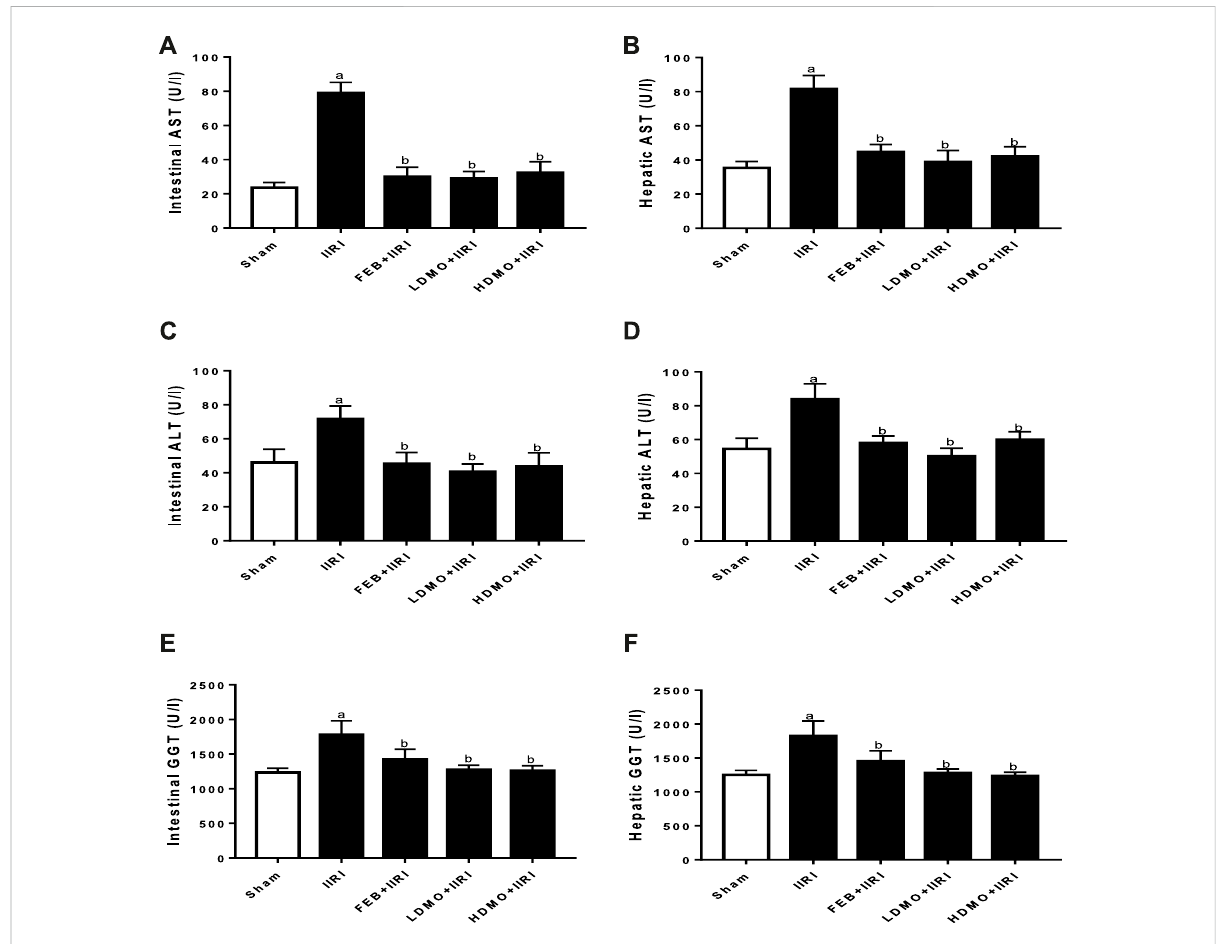
FIGURE 2 Effectofintestinalischaemia/reperfusion(I/R)andmethanolic Moringaoleifera leafextractonintestinal (A) andhepaticaspartatetransaminase, AST (B) , intestinal (C) and hepatic alanine transaminase, ALT (D) , and intestinal (E) and hepatic gamma-glutamyltransferase, GGT (F) . IIRI: Intestinal ischaemia/reperfusion injury, FEB: febuxostat, LDMO: low dose Moringa oleifera, HDMO: high dose Moringa oleifera, a p < 0.05 versus sham, b p < 0.05 versus IIRI. Data were analyzed by one-way ANOVA followed by Tukey ’ s post hoc test. Values are expressed as mean ± SD of 10 rats per